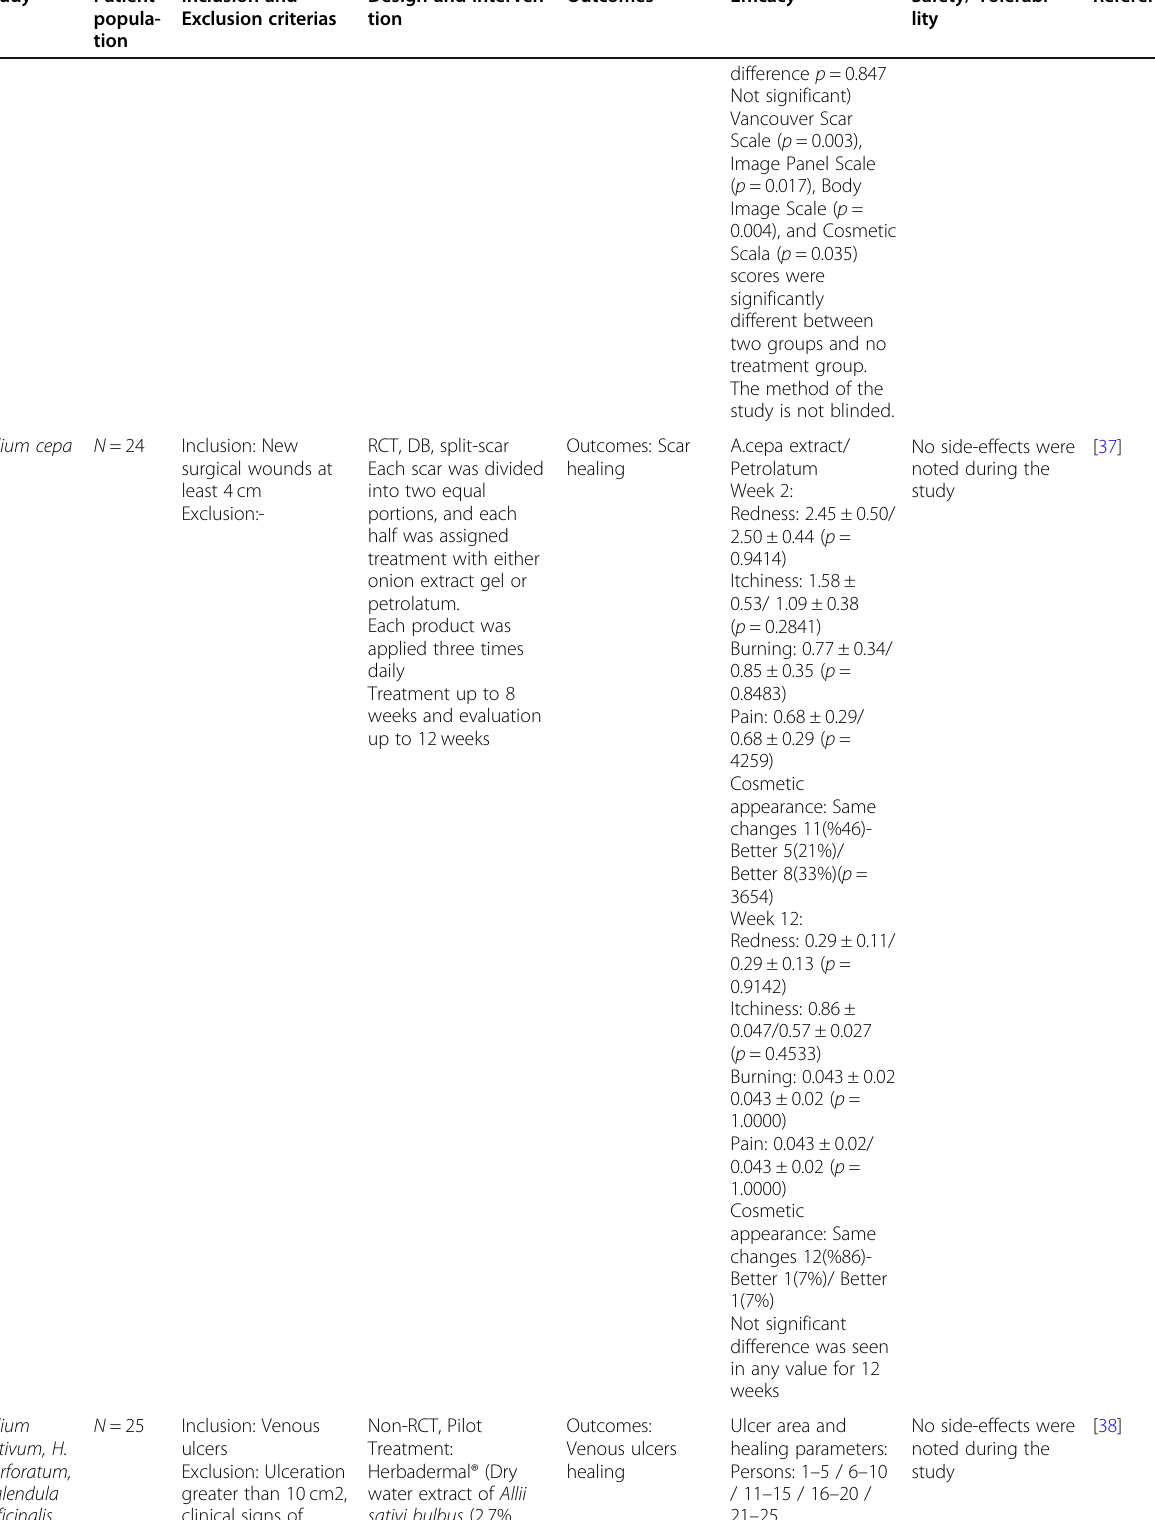
Table 4 Clinical trials of the traditional plants used for skin problems in Turkey (Continued) Study Patient